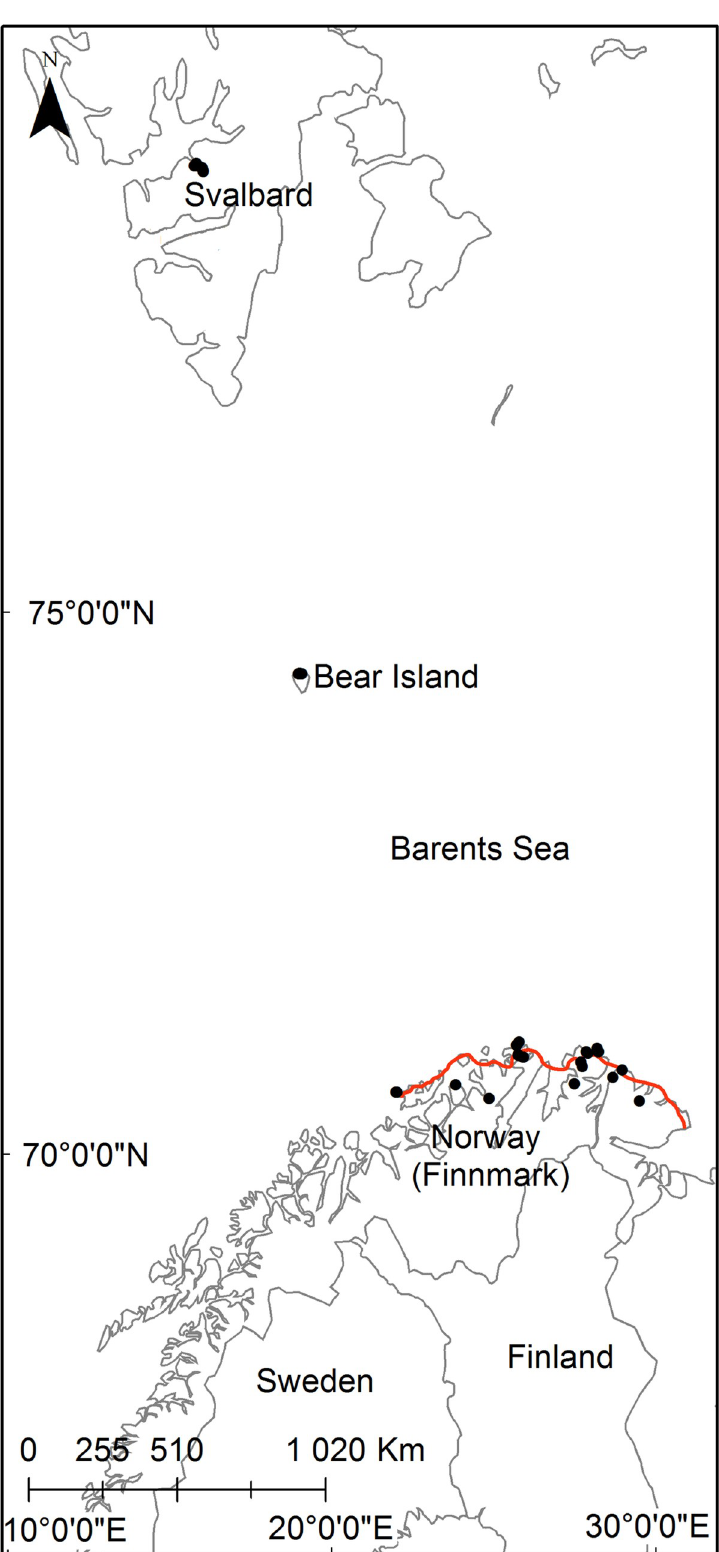
Fig 1. Map of study area. Black points indicate study areas. Red line in figure shows the northernmost distribution limit of birch forests in Finnmark. https://doi.org/10.1371/journal.pone.0239183.g001 PLOS ONE | https://doi.org/10.1371/journal.pone.0239183 September 17,